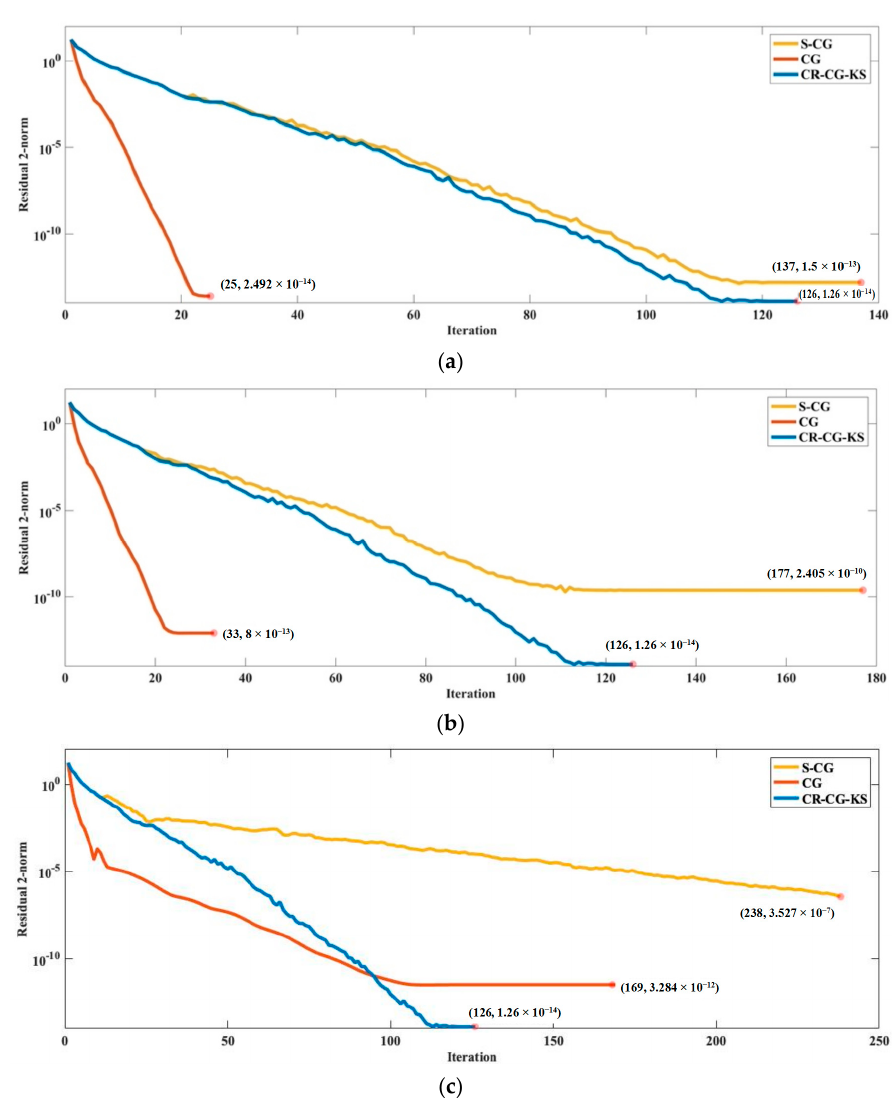
Figure 2. Algorithm iterative process comparisons (237 ports): ( a ) S = 4 ( b ) S = 8 ( c ) S = 12. From Figure 2a–c, the convergence speed of CG is always the fastest. However, its final convergence accuracy is worse than that of CR ‐ CG ‐ KS. During the early iteration period, the errors of S ‐ CG and CR ‐ CG ‐ KS are almost the same regardless of whether the inner loop step is 4, 8 or 12. However, the convergence speed of S ‐ CG becomes much lower than that of CR ‐ CG ‐ KS, and its final error is significantly larger. As S increases, the convergence speed of CG and S ‐ CG becomes slower, and their convergence accuracy be ‐ comes worse. The change of S has little effect on the convergence speed and accuracy of CR ‐ CG ‐ KS. The errors of CR ‐ CG ‐ KS always reach their minimum in the 126th iteration, and the minimum errors of CR ‐ CG ‐ KS are always 1.26 × 10 − 14 . It can be seen that the im ‐ provement of CR ‐ CG ‐ KS for the global container shipping network reconfiguration is sig ‐ nificant. Specifically, we compare the expected reference value of the global container ship ‐ ping network with the planned reconfiguration coefficients. The global container shipping